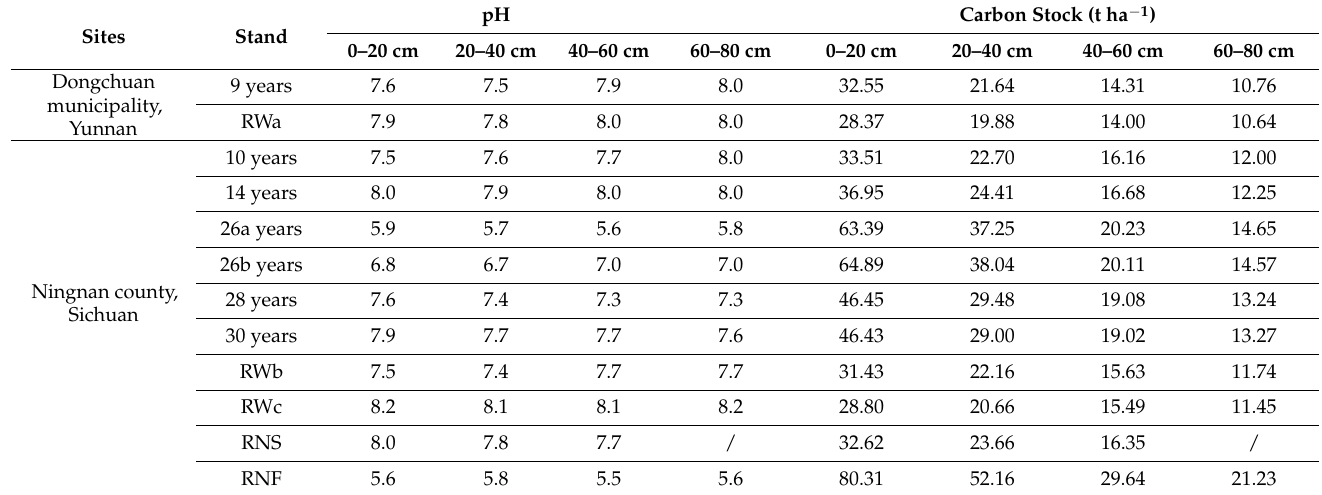
Table 2. Soil parameters including pH and soil organic stocks at each depth along the soil profile.